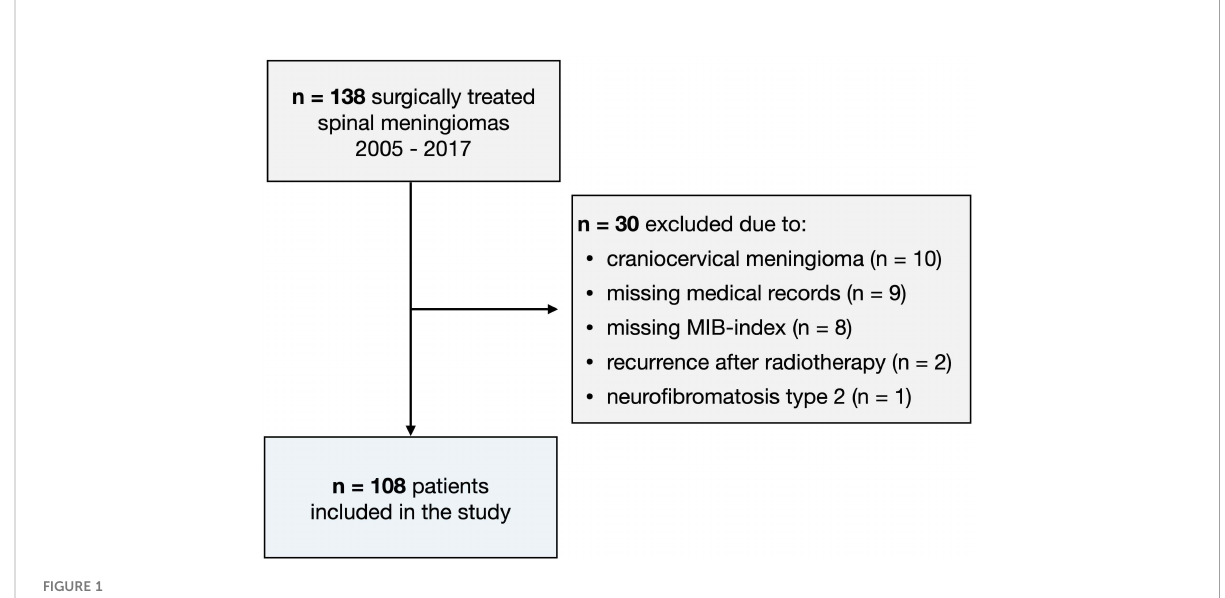
FIGURE 1 Flow-chart illustrating the patient inclusion